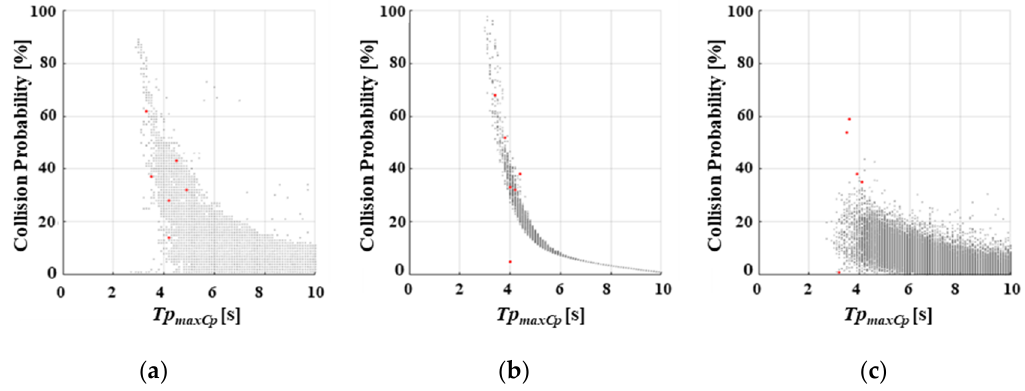
Figure 11. Human-centered threat assessment results. (a) Manual driving data; (b) NAS; (c) RNN.